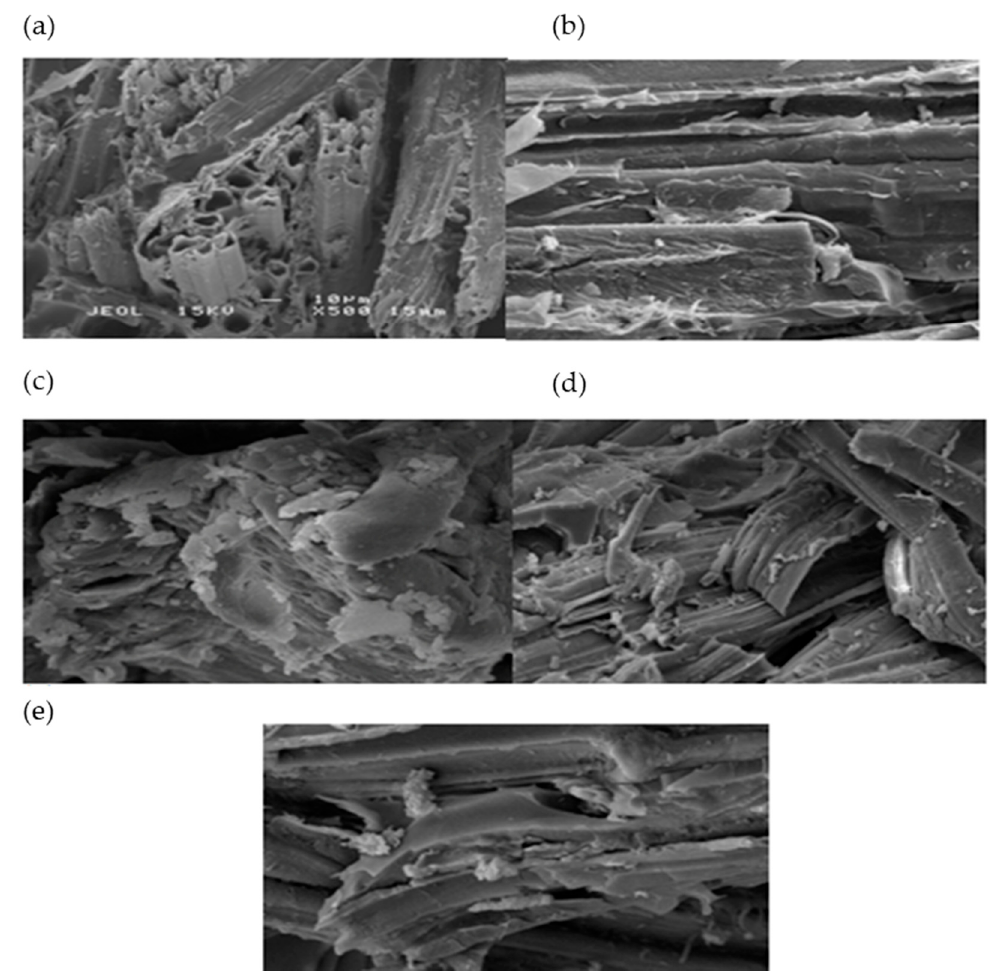
Figure 2. Scanning electron micrographs of tensile fracture of T1 composite ( a ), T5 composite ( b ),T2 hybrid composite ( c ), T3hybrid composite ( d ), T4 hybrid composite ( e ), scale bar = 10 μ m.